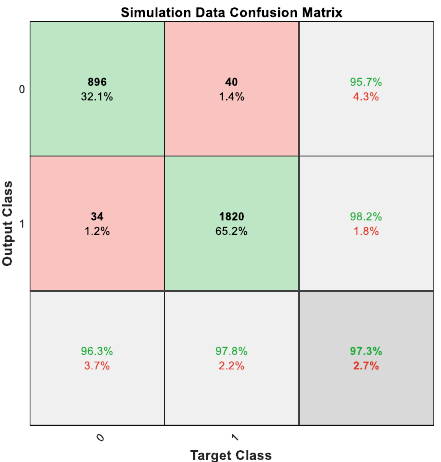
Figure 13. The confusion matrix plot of the simulation data of the final model produced by the random subspace kNN classifier.